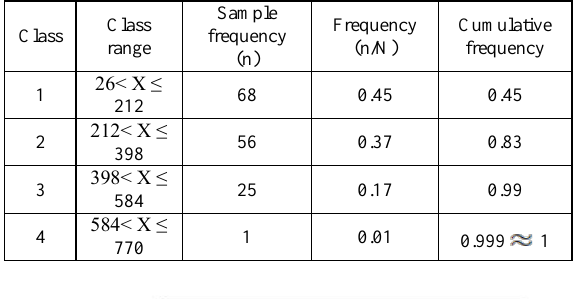
Figure 1. Investment costs versus wastewater flow